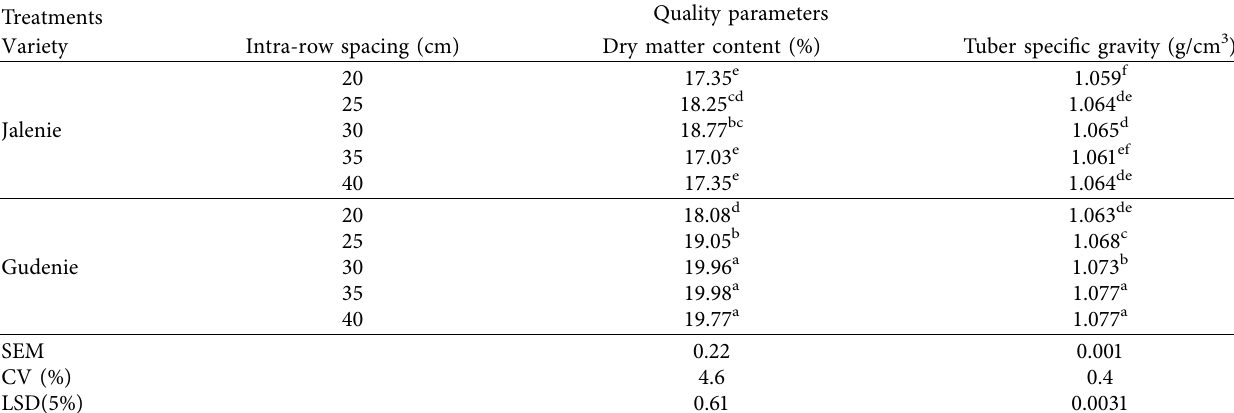
Table 8: Interaction effect of variety and intra-row spacing on quality parameters of potato in 2013/2014 at Nono Benja. Treatments